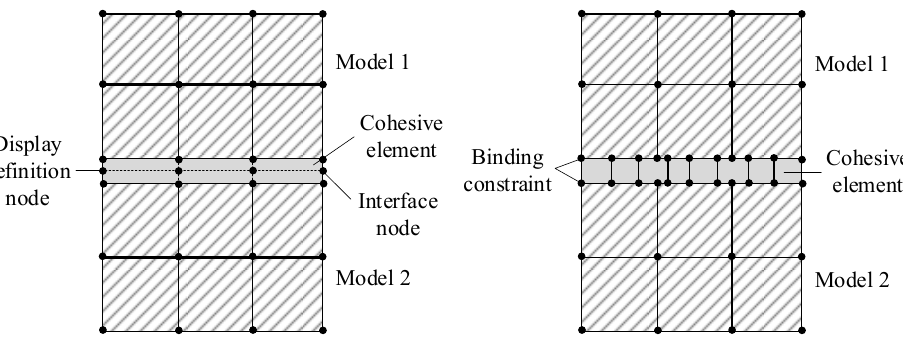
Figure 1. Schematic diagram of the contact-element modeling